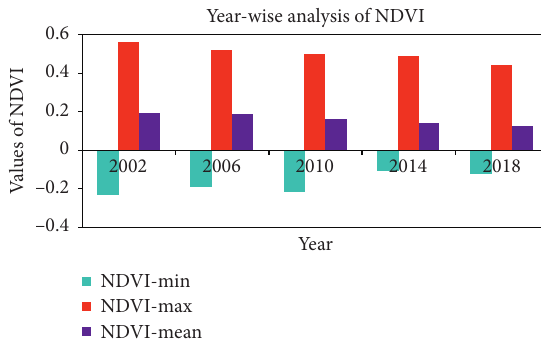
Figure 10: Year-wise analysis of